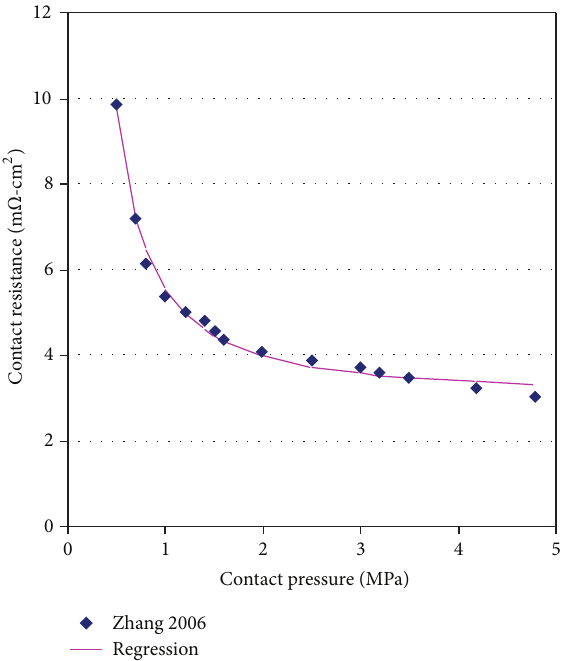
Figure 8: Modelling of contact resistance at the BPP and GDL inter- face.